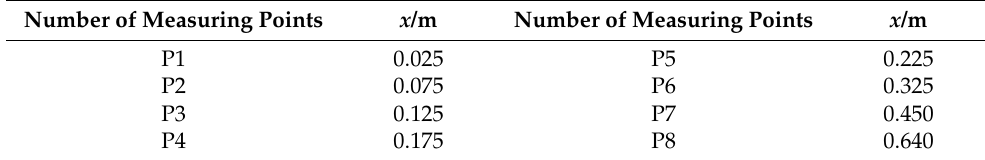
Table 2. The measuring point position table on the central axis of the bottom plate of the stilling pool. Number of Measuring